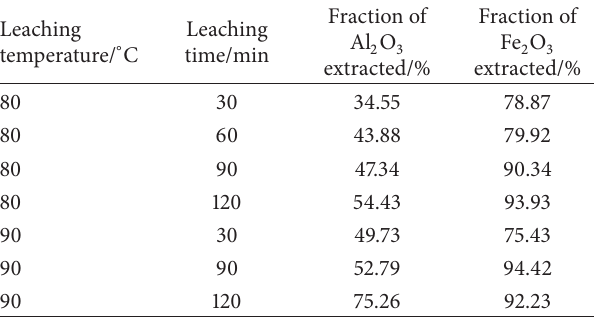
Table 1: Chemical compositions of raw bauxite mineral. Chemical